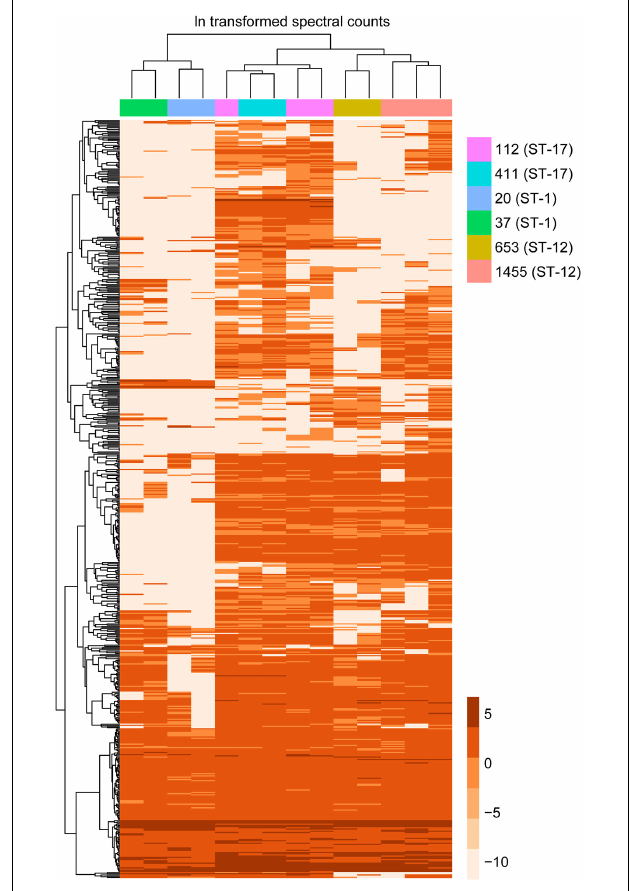
FIGURE 7 | Hierarchical clustering of membrane vesicle (MV) proteomes shows sequence type (ST) specific clustering. A heatmap was generated using hierarchical clustering with the pheatmap function in R, which uses Euclidean distance to cluster rows and columns with similar profiles. Individual rows represent a single accession number for an identified protein, with the color gradient of individual boxes corresponding to the natural log (ln) transformation of spectral counts for a given protein of interest. Columns represent a single proteomic sample, which are color coded by strain.